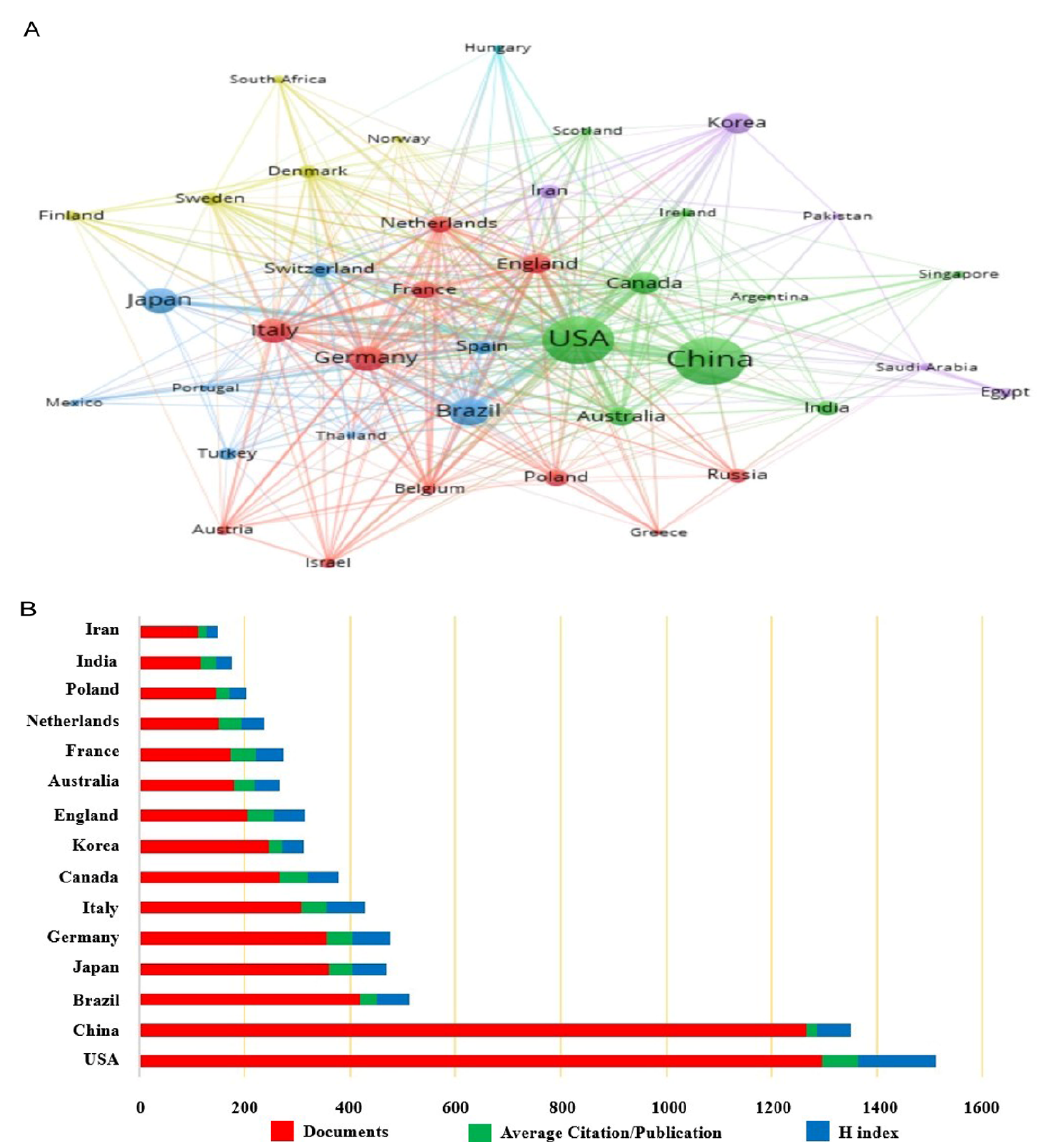
Figure 4. Contributions of countries or regions. ( A ) Mapping of the co-authorship analysis among the countries which published at least 18 papers on the association between depression and BDNF according to VOS viewer. Node sizes represent the volume of published literature. Node lines represent association strength. Node colors represent different clusters. ( B ) The total number of publications, average citation per item, and H index of the top 15